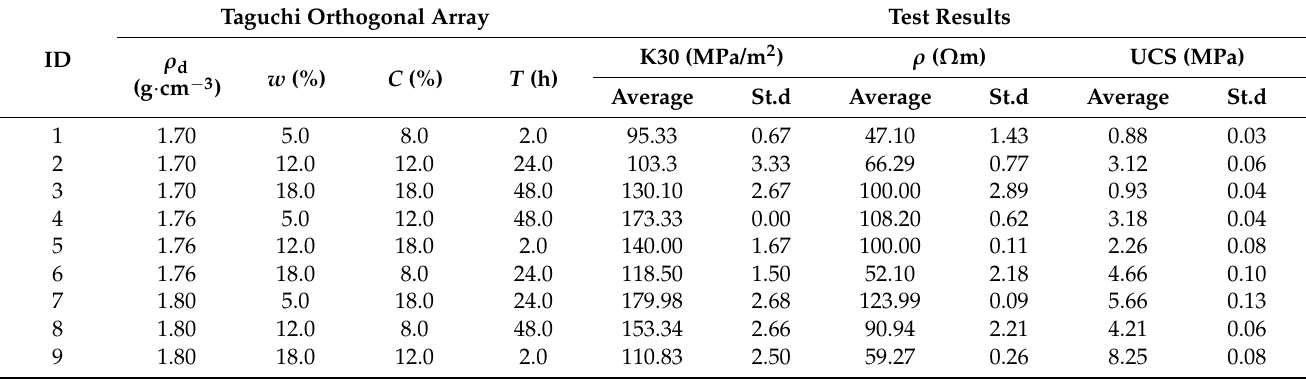
Table 2. Taguchi L9 Orthogonal array for conducting the design of experiments and test